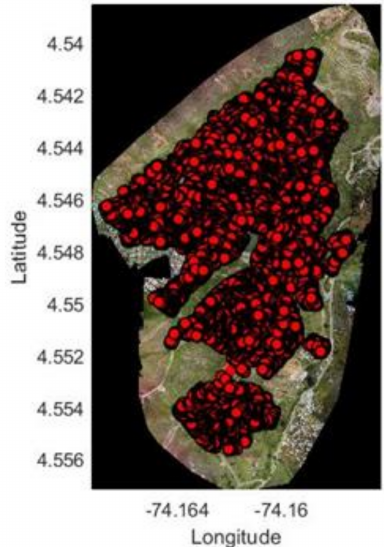
Figure 16. Building detected by satellite